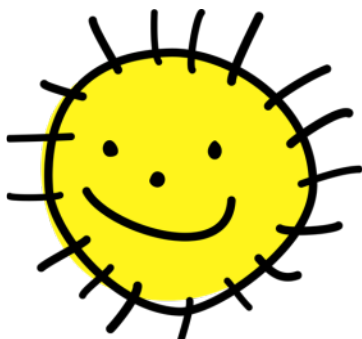
Figure 5. The SoL logo.